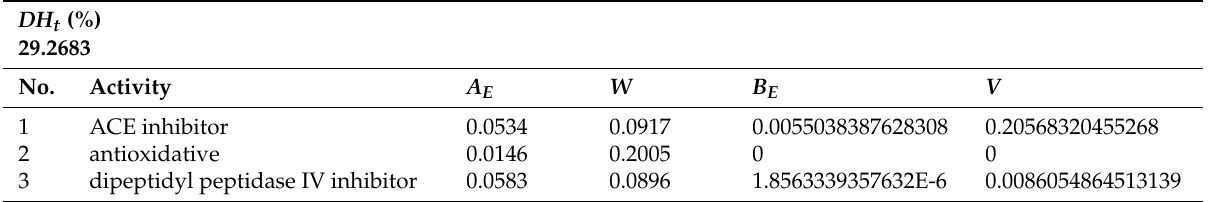
Table A54. A E , DH t , W , B E and V values from RubisCO of Halophila stipulacea . In silico enzymatic cleavage was carried out by using